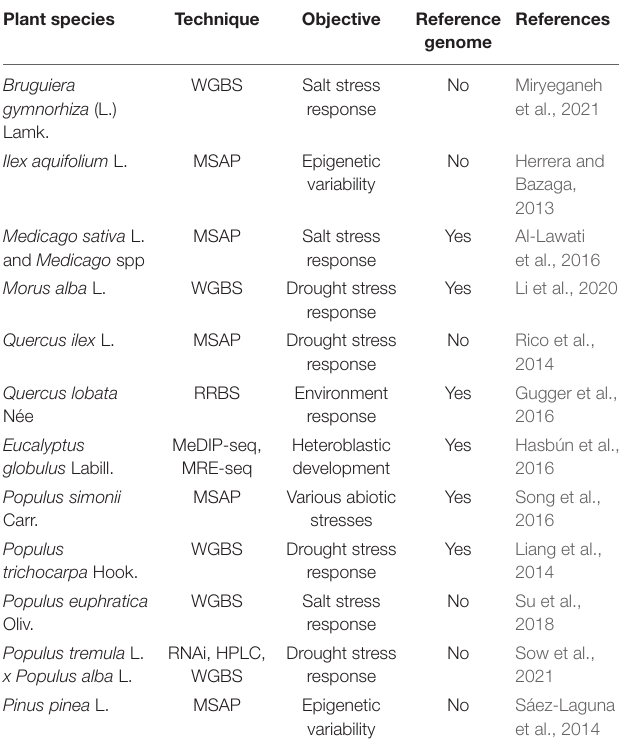
TABLE 2 | Brief description of some DNA methylation studies carried out with the main objective of studying plant species response to several abiotic stresses. Plant